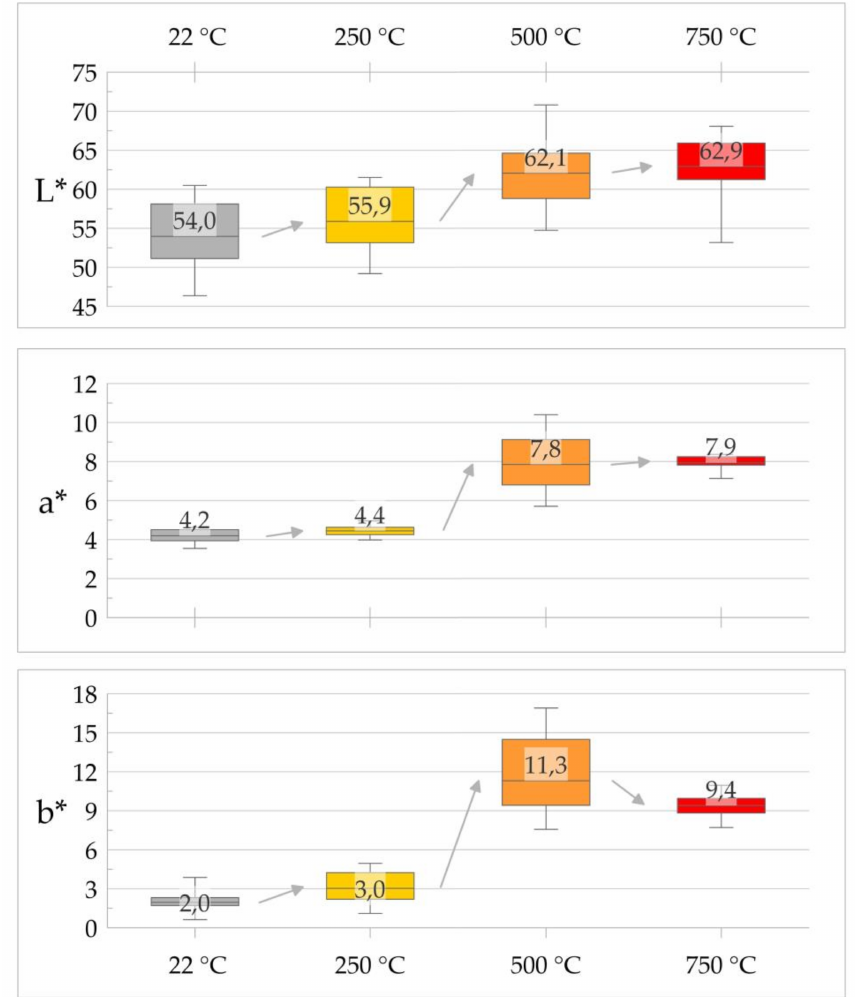
Figure 6. Box Plot diagrams of CIE L*a*b* color space values (L*—Lightness, a*—Red/Green value, b*—Blue/Yellow value) as a function of